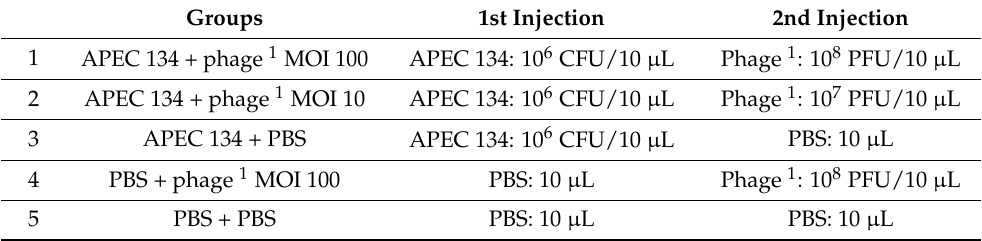
Table 1. Summary table of the groups of G. mellonella larvae inoculated for the survival and titration